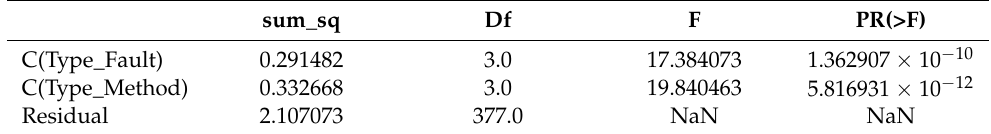
Table 9. Anova2 testes: simulated cases.